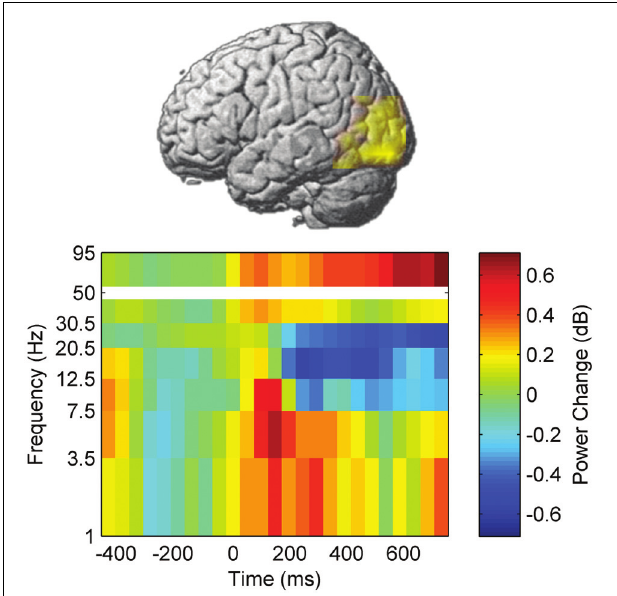
FIGURE 4 | Naming-related power changes before training. Time 0 corresponds to picture